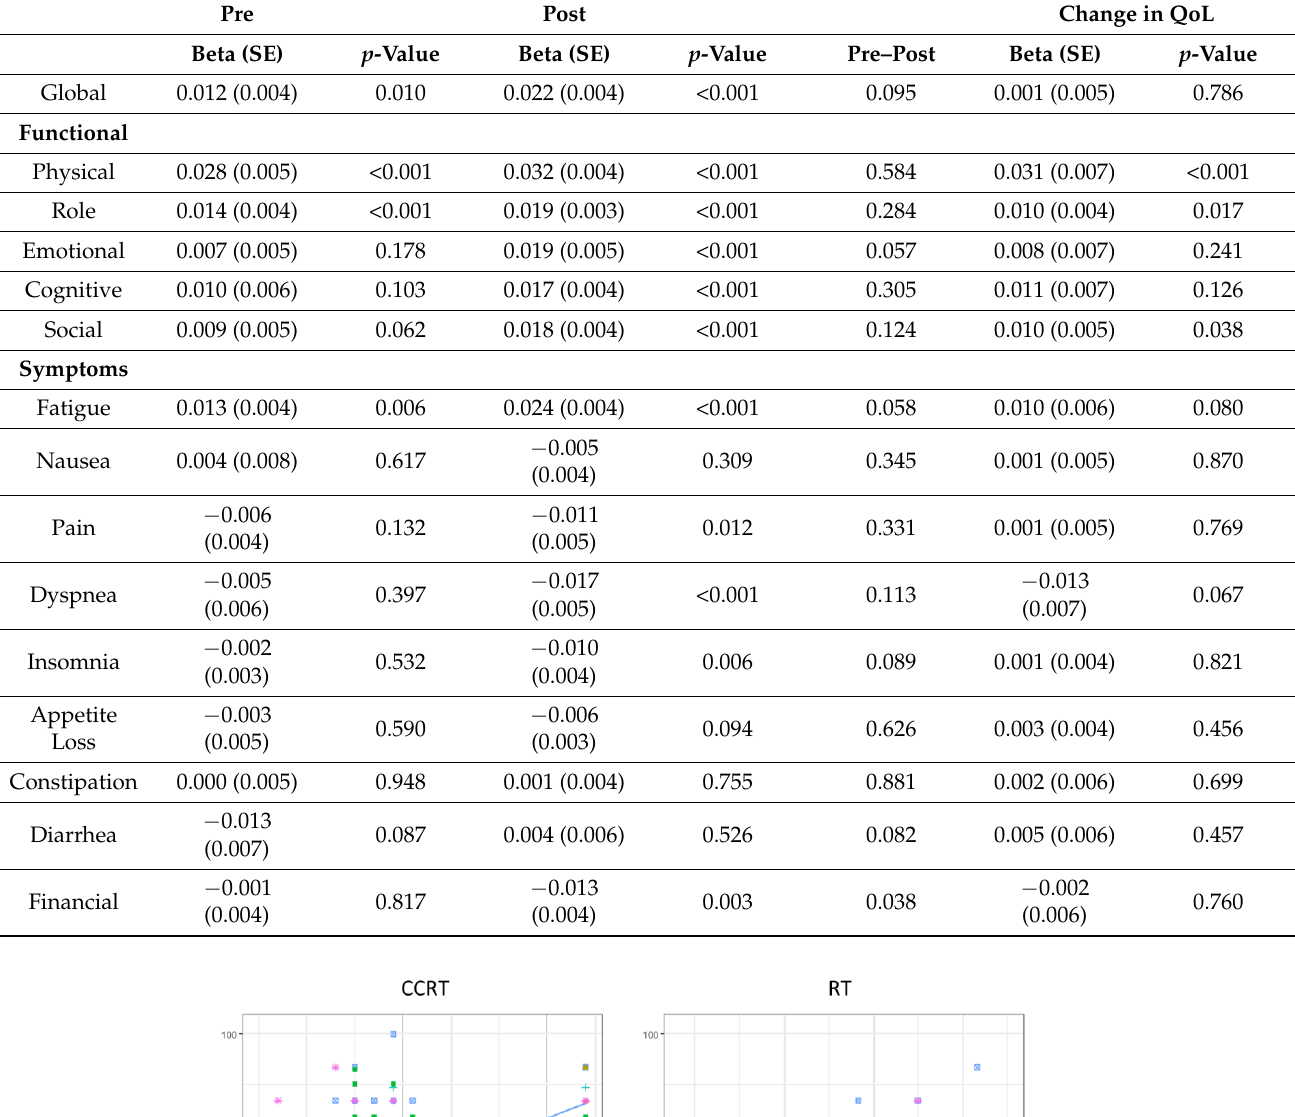
Table 3. Correlation between the SPPB and quality of life (QoL) for the CCRT group.